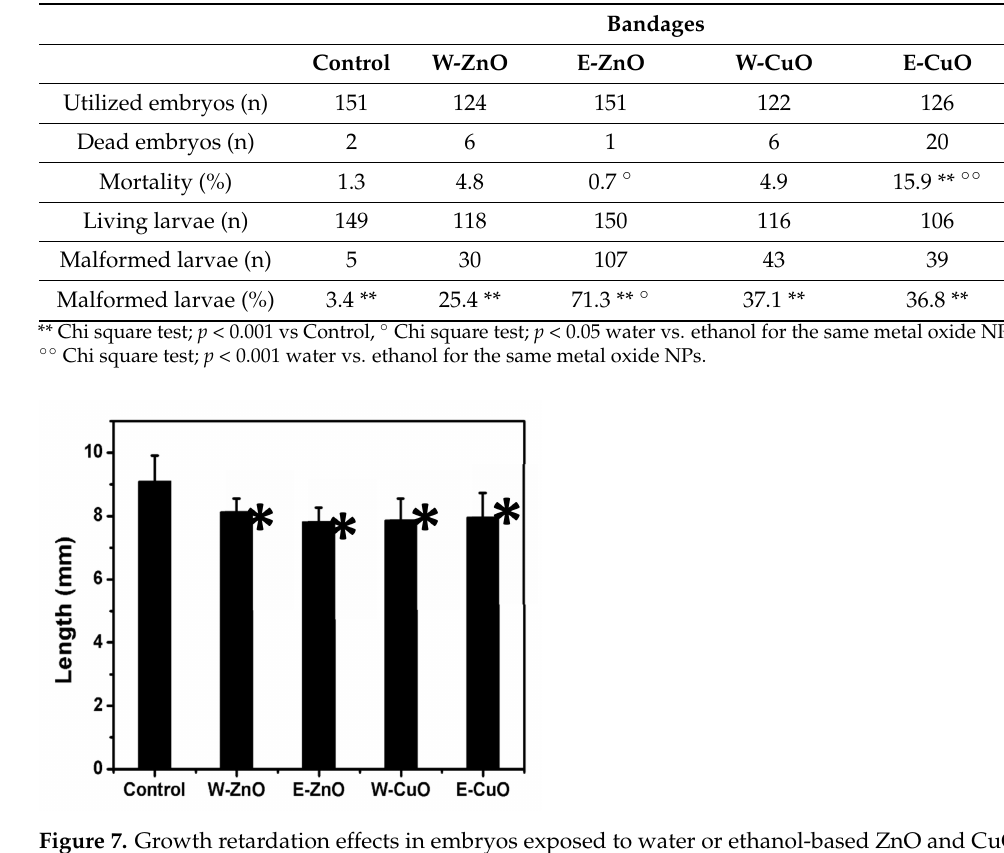
Table 2. Embryotoxic effects in X. laevis .